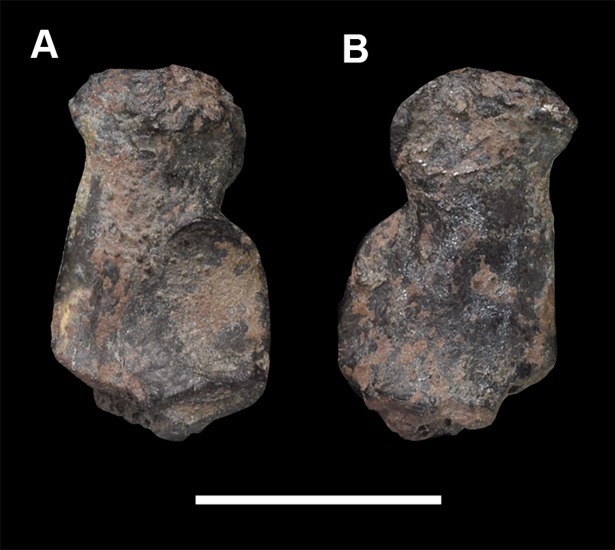
Pisiform of Periptychus carinidens (NMMNH P-47693).(A) dorsal view; (B) plantar view. Scale bar: 30mm.